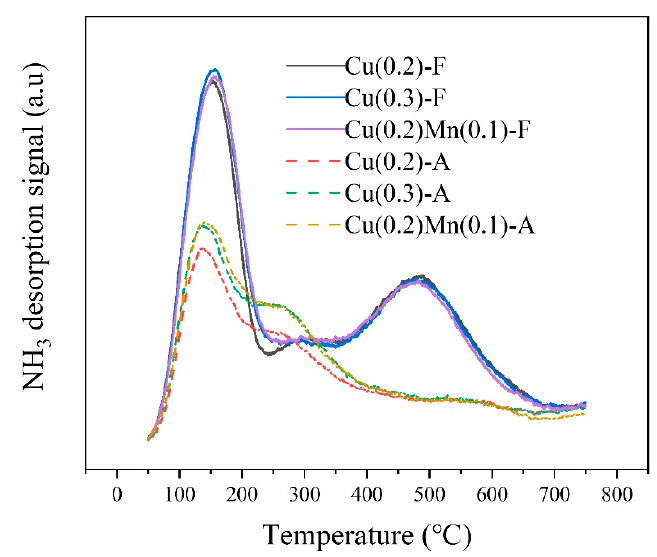
Figure 5. Temperature-programmed desorption with NH 3 (NH 3 -TPD) curves of catalysts before and after hydrothermal aging.